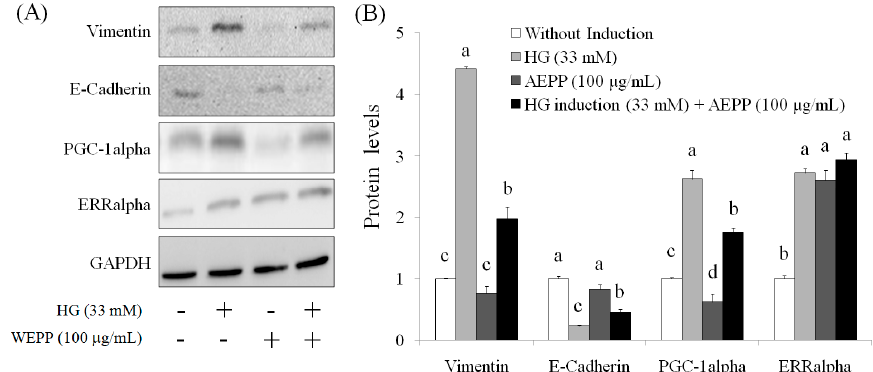
Figure 5. The inhibition of high-glucose-induced ( A ) EMT markers by Western blot and ( B ) the results of quantity analysis in OVCAR-3 carcinoma cells treated by AEPP for 24 h. Data were shown as mean ± SD ( n = 3). A significant difference between groups in the same protein is shown by different letters ( p < 0.05).